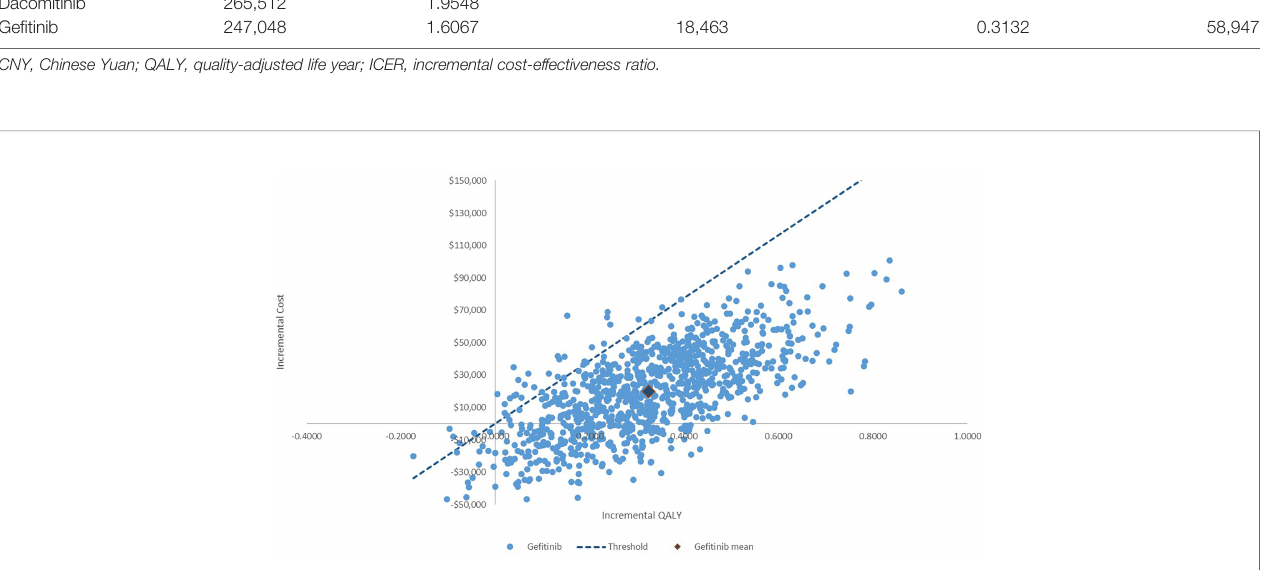
TABLE 3 | Base case results of the cost-effectiveness analysis.